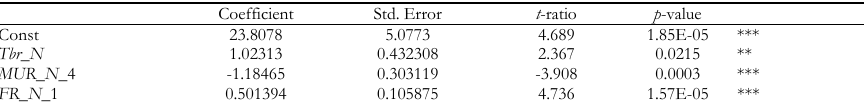
OLS in Northern regions of Italy (adj. R 2 = 0.86) Coefficient Std.